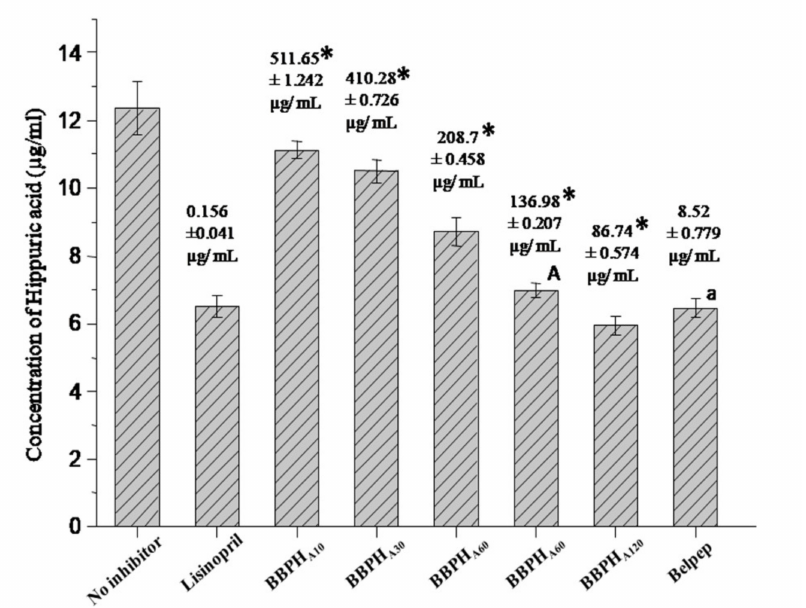
Figure 1. ACE inhibitory activity of B. bengalensis protein hydrolysates at different gradient times (10 min, BBPH A10 ; 30 min, BBPH A30 ; 60 min, BBPH A60 ; 90 min, BBPH A90 ; 120 min, BBPH A120 ) and the synthesized peptide (Belpep). IC 50 values of each reaction set are shown over each bar as mean ± SD value, n = 3. The capital letter indicates the significant reduction inhippurate release ( p < 0.05), as affected by BBPH A90 , in comparison to BBPH A60 ( p = 0.01987). The asterisk (*) indicat- esthe significant difference between the IC 50 values of hydrolysates of two subsequent time points (BBPH A10 vs. BBPH A30 ( p = 0.0000139); BBPH A30 vs. BBPH A60 ( p = 0.0000029); BBPH A60 vs. BBPH A90 ( p = 0.0000075); BBPH A90 vs. BBPH A120 ( p = 0.0000211)). The lowercase letter signifies the significant difference in the IC 50 values of Belpep and BBPH A120 ( p =